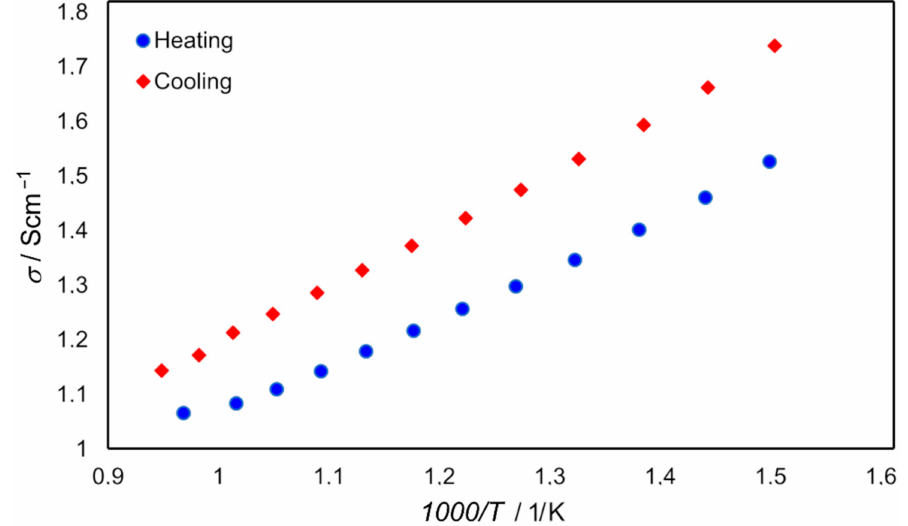
Figure 16. Electrical conductivity ( σ ) of the reduced Ni–5CBCY sample vs. temperature.